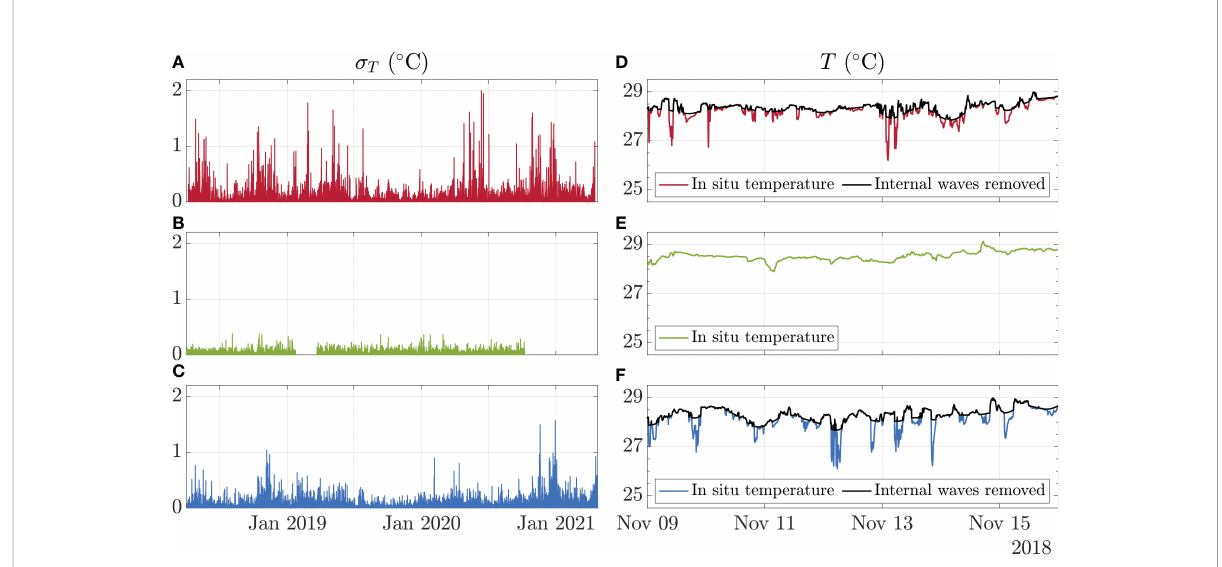
FIGURE 3 The hourly standard deviation of temperature across (A) Ile Anglaise (red), (B) Ile du Coin (green), and (C) Moresby (blue) between April 2018 and April 2021, as well as in situ temperature pro fi les, alongside modelled temperature pro fi les with internal waves removed, over the same 2-week period, across (D) Ile Anglaise, (E) Ile du Coin, and (F) Moresby. Note that no internal waves were detected in Ile du Coin, and therefore no model removing internal waves was